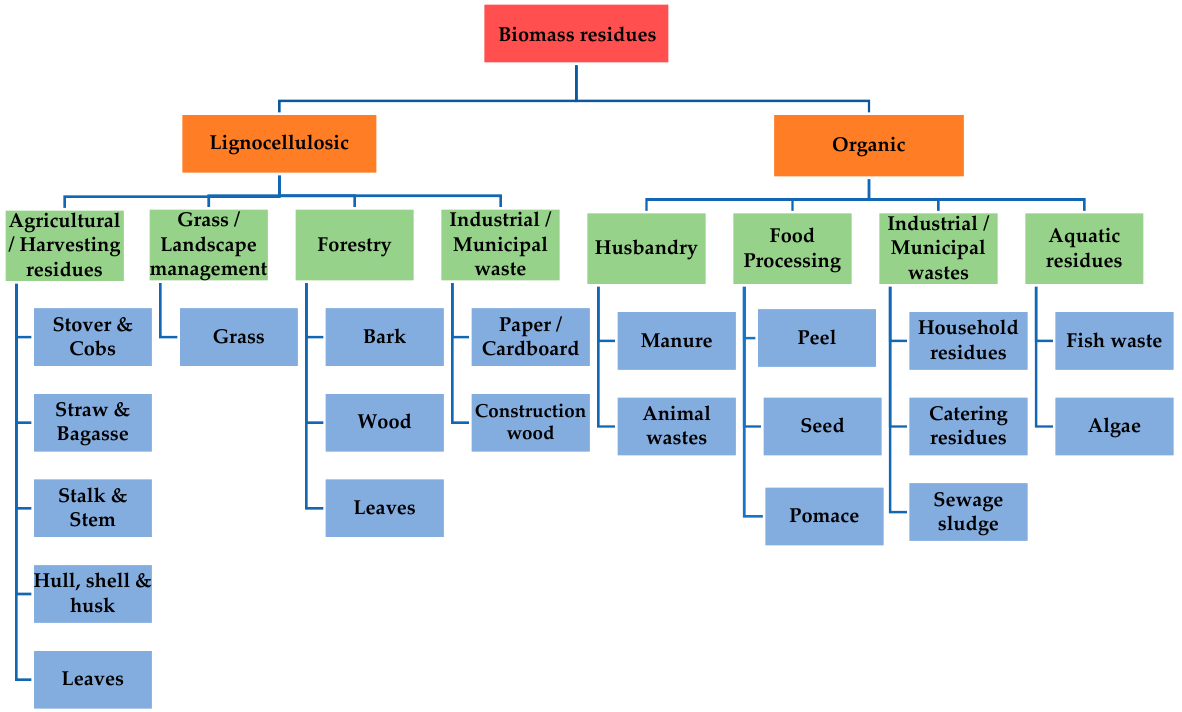
Figure 2. Residue origin and classification.